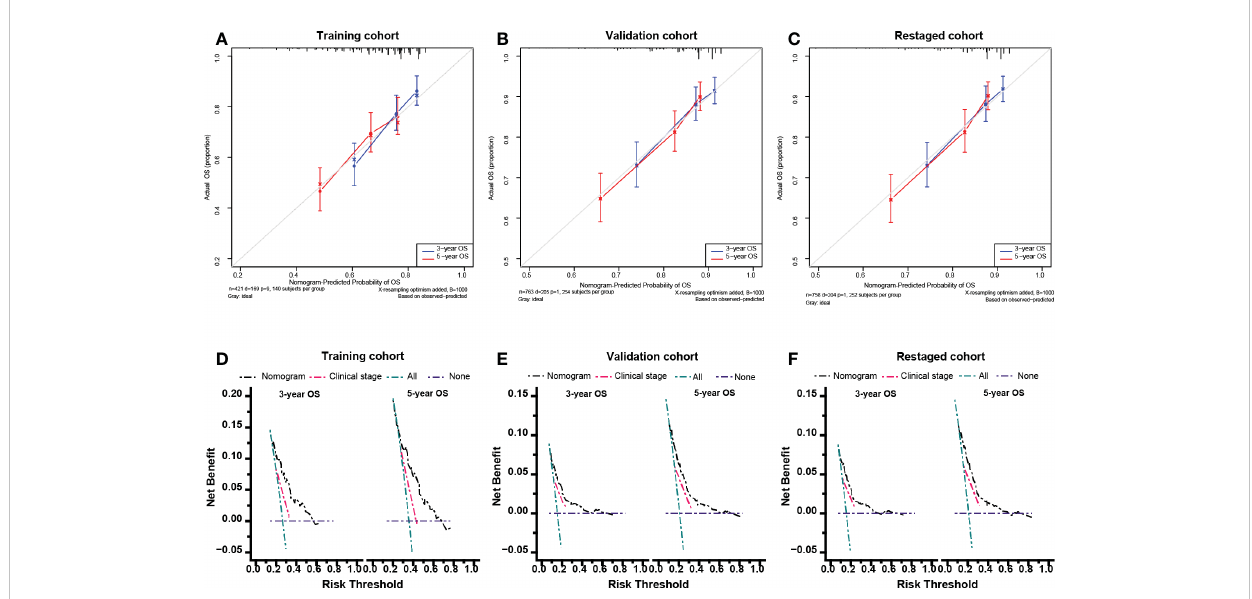
FIGURE 5 Calibration curves and Decision curve analysis. Calibration curves for 5-year overall survival in the training cohort (A) , validation cohort (B) and re- staged cohort (C) . Decision curve analysis for 5-year overall survival in the training cohort (D) , validation cohort (E) and re-staged cohort (F) .